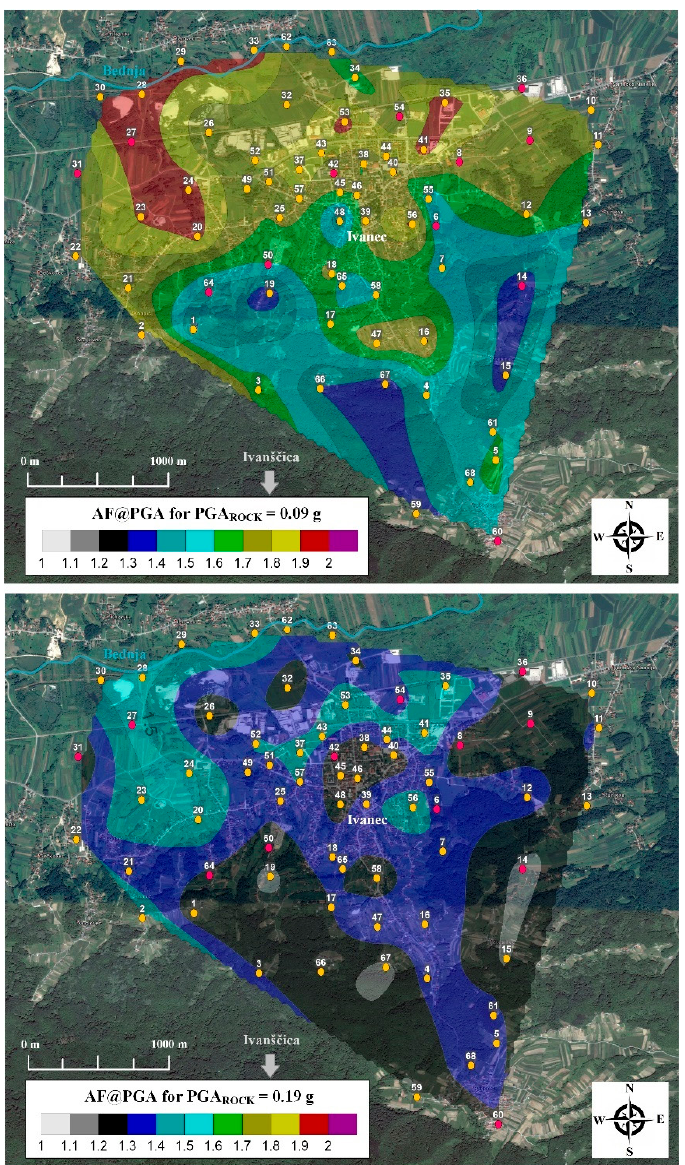
Figure 14. Up: Map of site response amplification factor at surface peak ground acceleration PGA for input PGA ROCK = 0.09 g (95yrp). Bottom: Map of site response amplification factor at surface peak ground acceleration PGA for input PGA ROCK = 0.19 g (475 yrp).